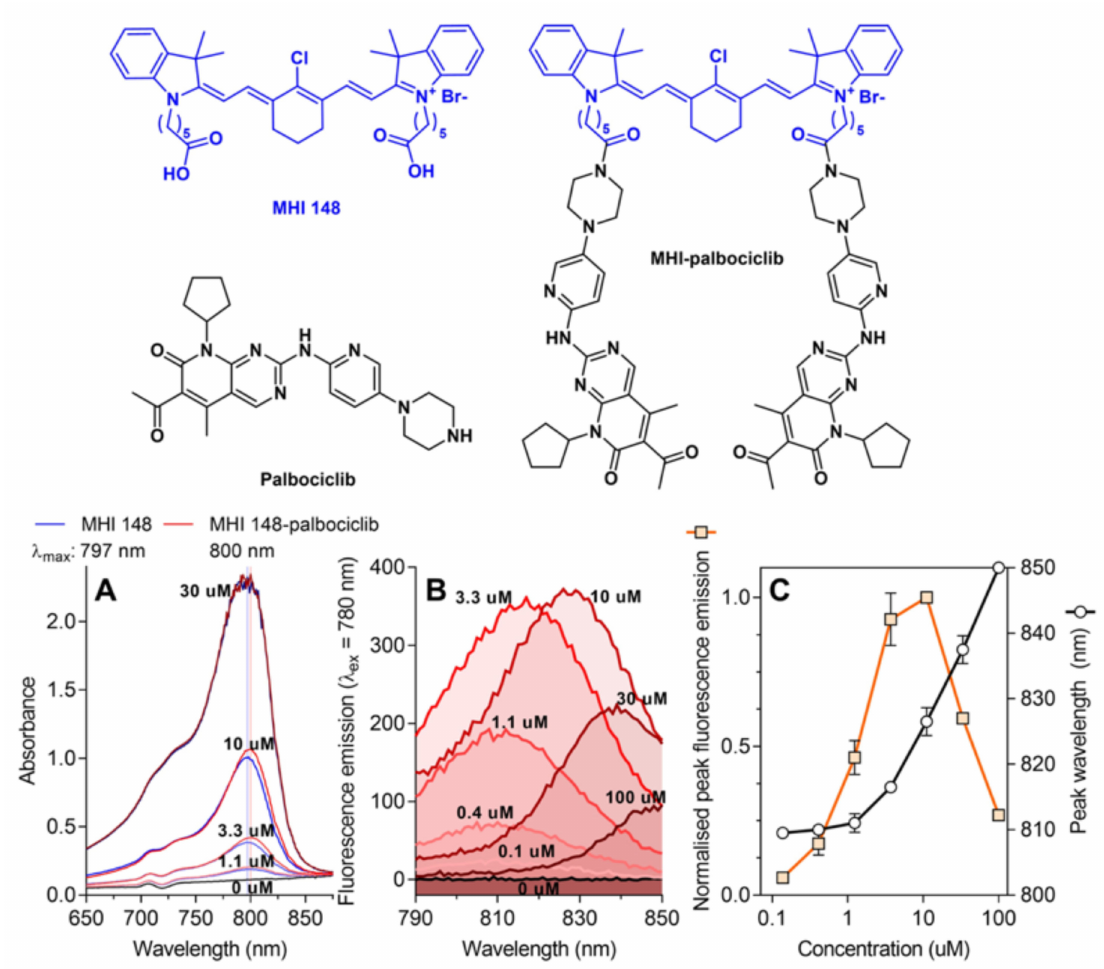
Figure 1. The conjugation of palbociclib to MHI-148 does not significantly influence the absorbance and fluorescence properties of the parent MHI-148 dye. ( A ) Absorbance spectra of MHI-148 and MHI-palbociclib in DMSO. A representative experiment of two independent repeats. Vertical lines denote λ max , which indicates the wavelength at the peak maximum. ( B ) Fluorescence spectra of MHI-palbociclib in DMSO. Each fluorescence emission spectrum represents an average of three mea- surements. Only MHI-palbociclib is displayed, as MHI-148 showed essentially identical normalised spectra. ( C ) Impact of fluorophore concentration on fluorescence intensity and peak wavelength. Each data point represents a mean and standard deviation of respective values for MHI-148 and MHI-palbociclib obtained from data in panel ( B ). Increasing MHI-palbociclib’s concentration redshifts the fluorescence and induces